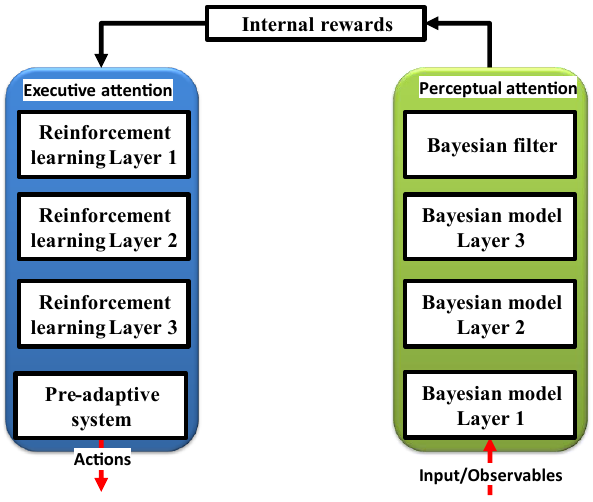
Figure 5. Attention/focusing in the CDS [11].